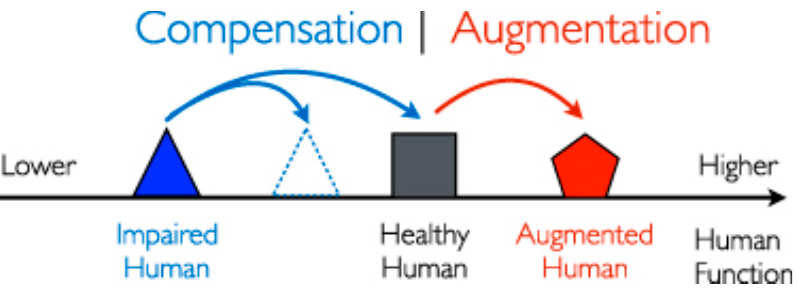
Figure 8. Human augmentation [47].